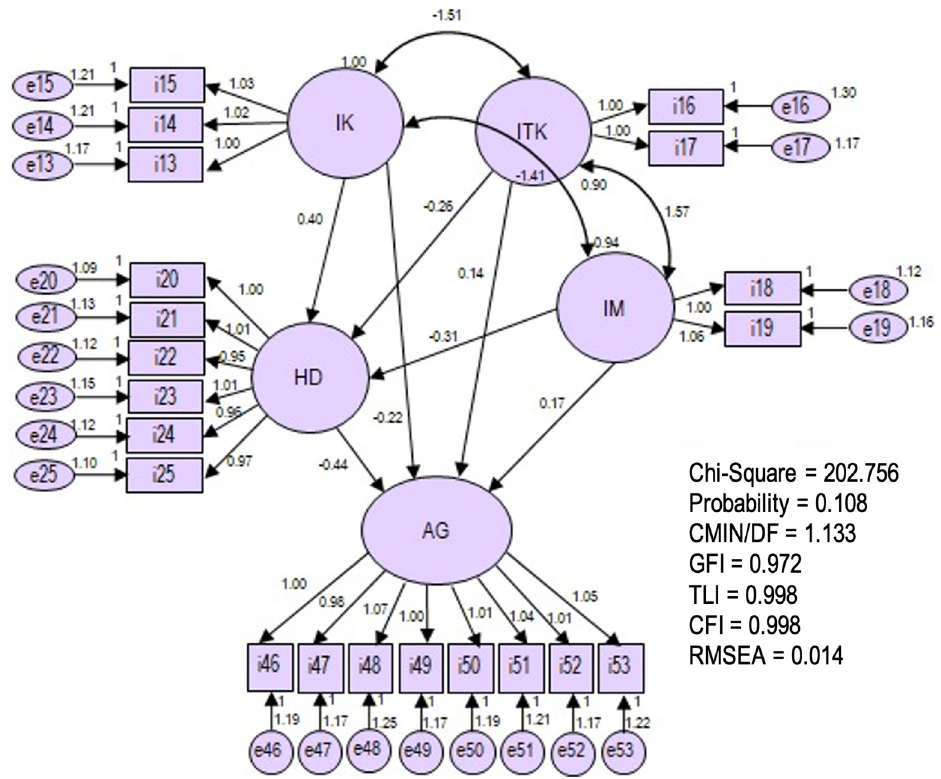
Figure 2. The final model paths. Note : Secure attachment (IK), Insecure Attachment (ITK), Anxious Attachment (IM), Self-Esteem (HD), Aggression (AG). The error standard (e13–e25; e46–e53). The indicator of secure attachment: warm (i13), responsive (i14), sensitive (i15). The indicator of insecure attachment: sceptical (i16), submissive (i17). The indicator of anxious attachment: insensitive (i18), less involved (i19). The indicator of self-esteem: self-regulation (i20), adaptive responsiveness (i21), self-assessment (i22), competence and achievement (i23), understanding self-capacity (i24), adherence to values (i25). Aggression indicators: direct physical active (i46), direct physical passive (i47), indirect physical active (i48), indirect physical passive (i49), direct verbal active (i50), direct verbal passive (i51), indirect verbal active (i52), passive indirect verbal (i53). The Minimum Sample Discrepancy Function Divided with degree of Freedom (CMIN/DF), Goodness of Fit Index (GFI), Tucker–Lewis Index (TLI), Comparative Fit Index (CFI), Root Mean Square Error of Approximation (RMSEA).